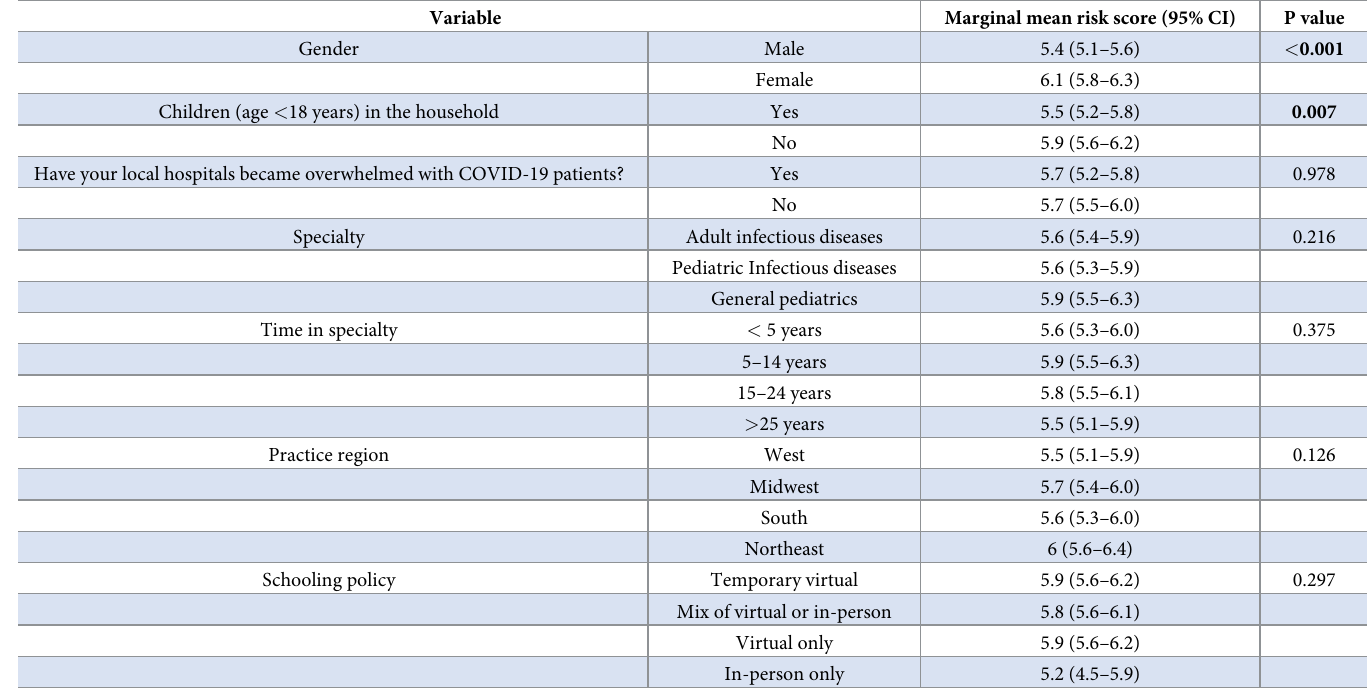
Table 3. Calculated marginal mean risk score and p values from the generalized linear model for predictors of risk of SARS-CoV-2 transmission in social